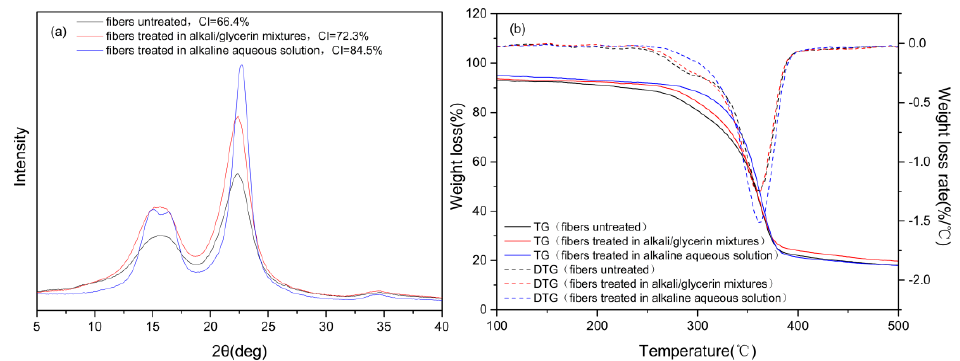
Figure 8. ( a ) X-ray diffraction intensity and ( b ) TG/DTG curves of the cotton stalk fibers treated in the alkali/glycerin mixtures compared with those of the fibers treated in the alkaline aqueous solu-